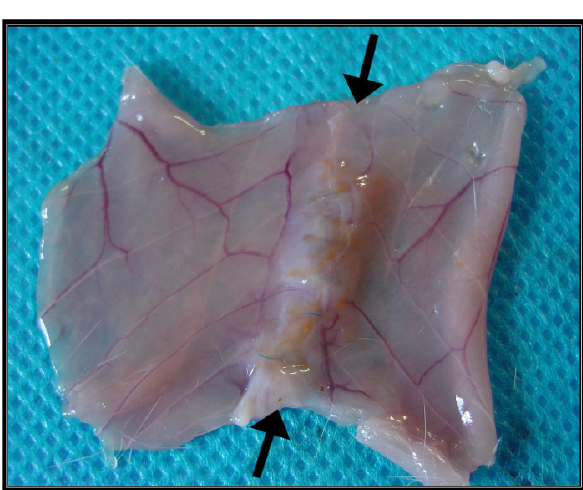
FIGURA 1 - Parede abdominal anterior ressecada. no 7ºdia de P.O. Nota: Setas = ferida cirúrgica e